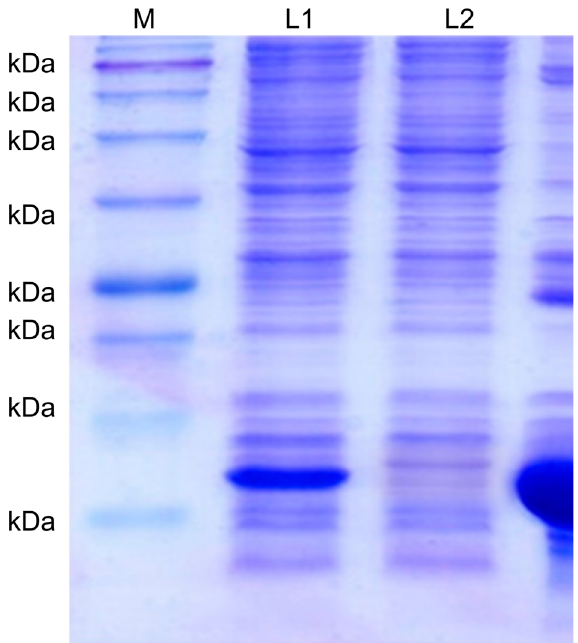
Figure 3. SDS-PAGE analysis of the NT-proBNP recombinant protein. M: protein marker (kDa); L1: